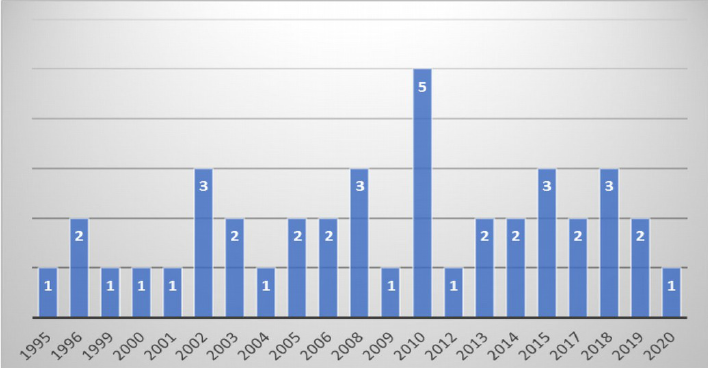
Figure 4. Frequency of TOC-DBR selected papers, 1990-2020